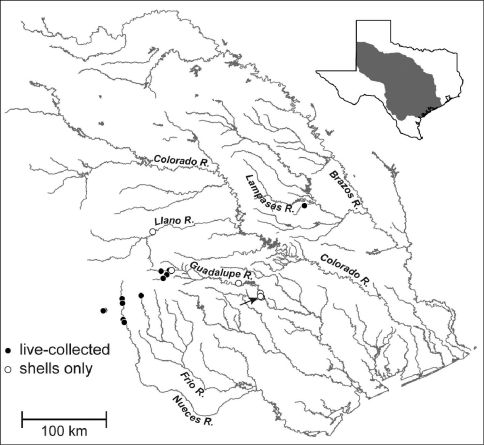
Map showing the distribution of Marstonia comalensis in the Brazos, Colorado, Guadalupe and Nueces River basins, south-central Texas. The arrow indicates the type locality (Comal Creek).